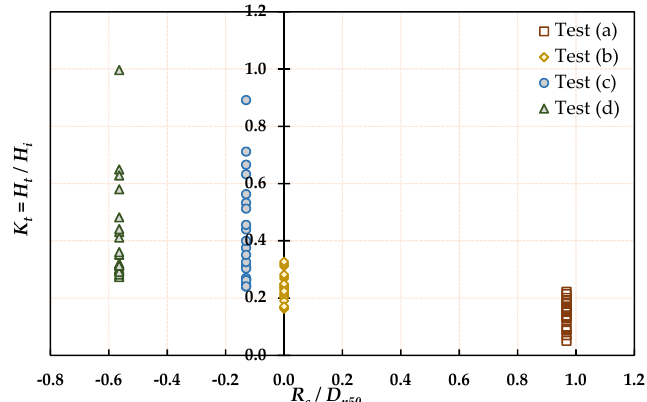
Figure 5. Effect of relative freeboard ( R c / D n 50 ) on wave transmission ( K t ).